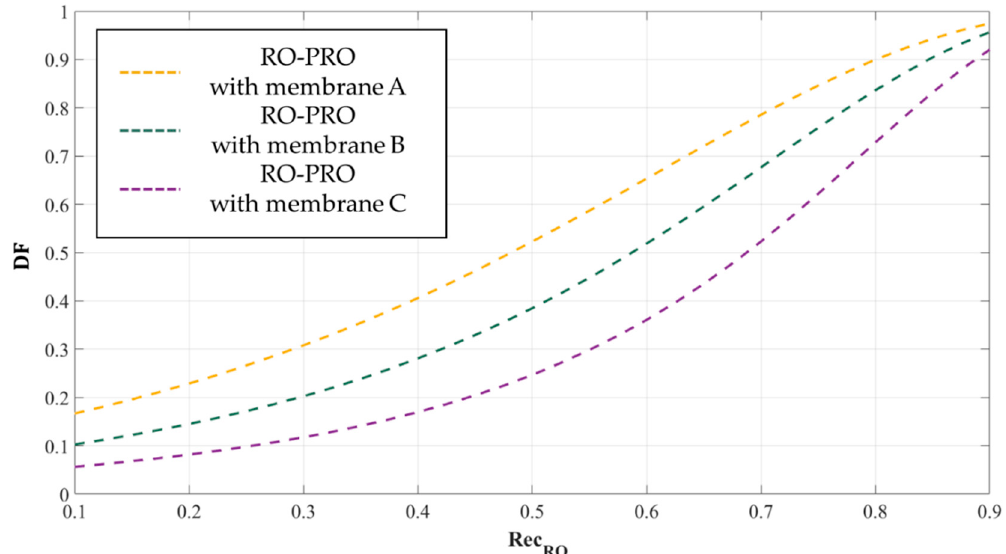
Figure 10. The relationship between the water recovery rate ( Rec RO ) of an RO process and the dilutive factor ( DF ) of a PRO process in an RO-PRO hybridized process. Dashed graph lines in this figure clearly show that the values of DF increase as Rec RO becomes higher. In this figure, membrane performances: membrane A > membrane B > membrane C; and C F , b , RO = 35,000